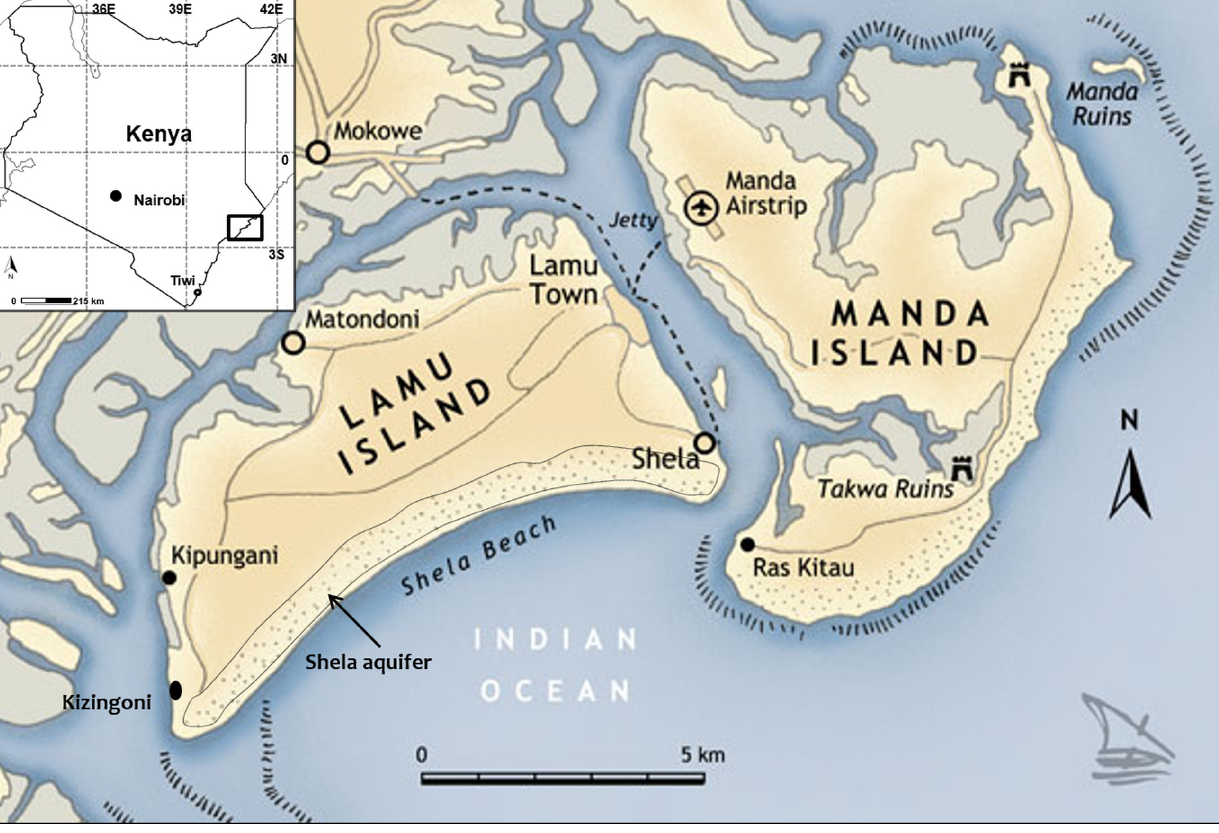
Figure 1. Map showing the location of the unconfined part of the Shela aquifer under the sand dunes south of Lamu Island, Kenya (adapted and modified from